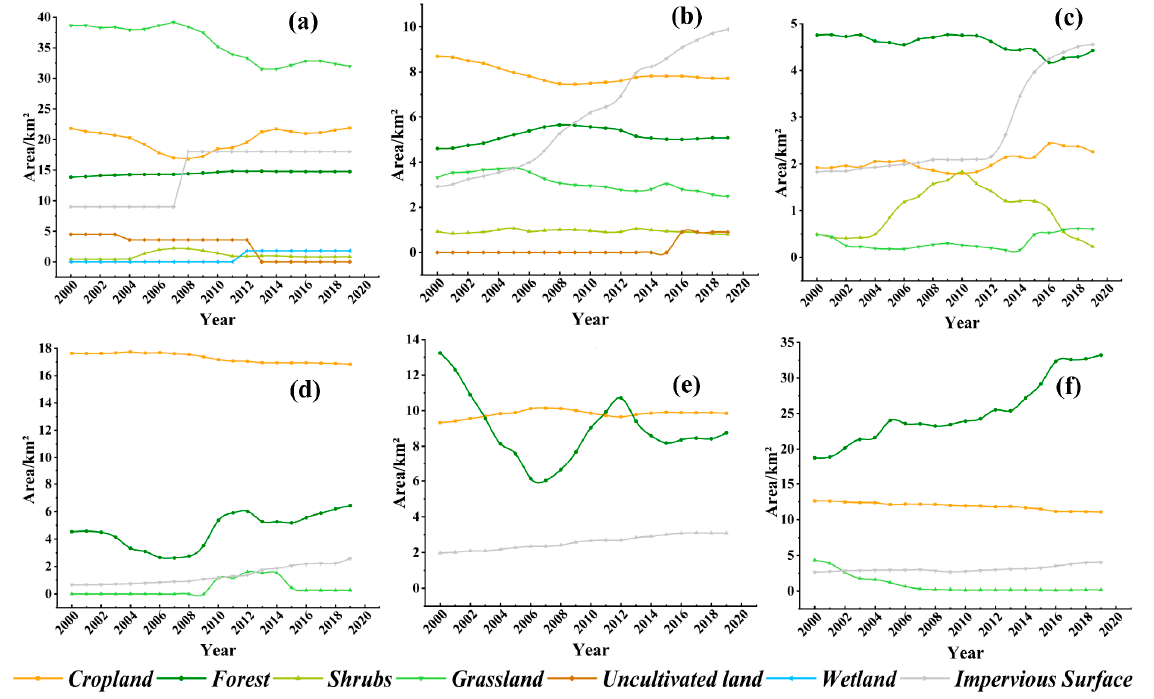
Figure 14. Land cover change of selected lakes from 2000 to 2019. ( a ) Lugu Lake; ( b ) Qionghai Lake; ( c ) Ma Lake; ( d ) Three Forks Lake; ( e ) Luban Reservoir; ( f ) Shengzhong Reservoir. Note, the types of land cover represented by the different colored lines is shown at the bottom of the figure.